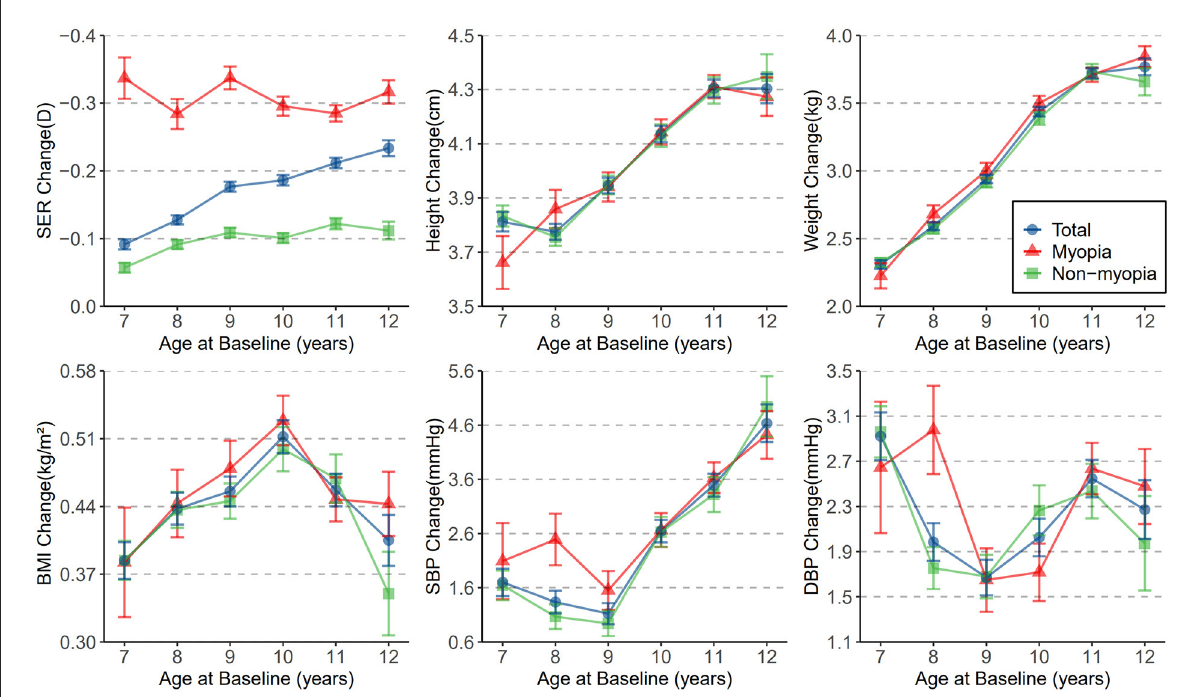
FIGURE2 The distribution of mean change in SER, height, weight, BMI, SBP, and DBP with age at baseline. Dots represents means and whiskers indicate SEM.